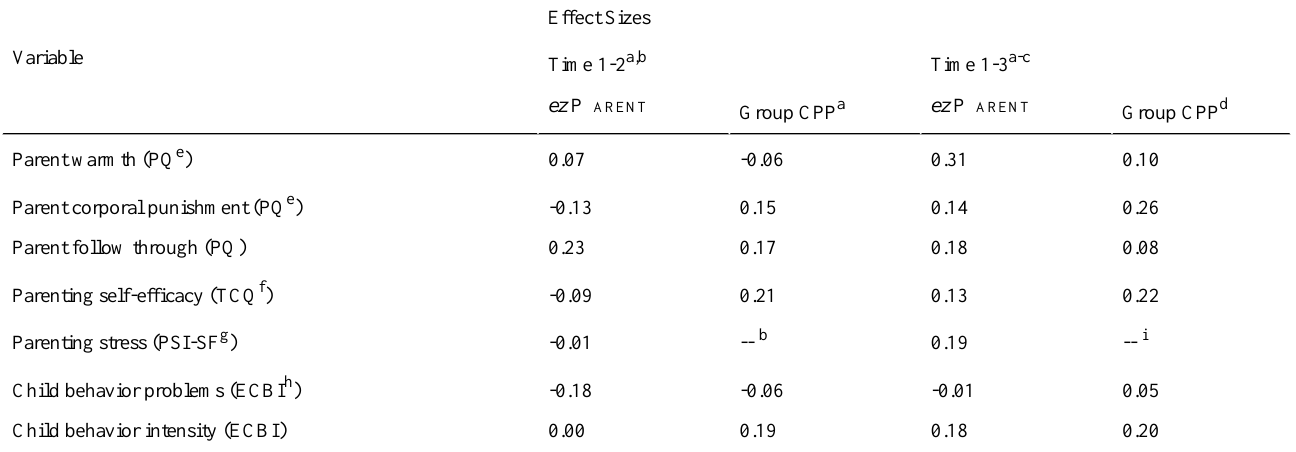
Table 4. Comparison of between group effect size estimates of ez P ARENT Program (n=40 control; n=39 intervention) and group CPP (n=237 control; n=267